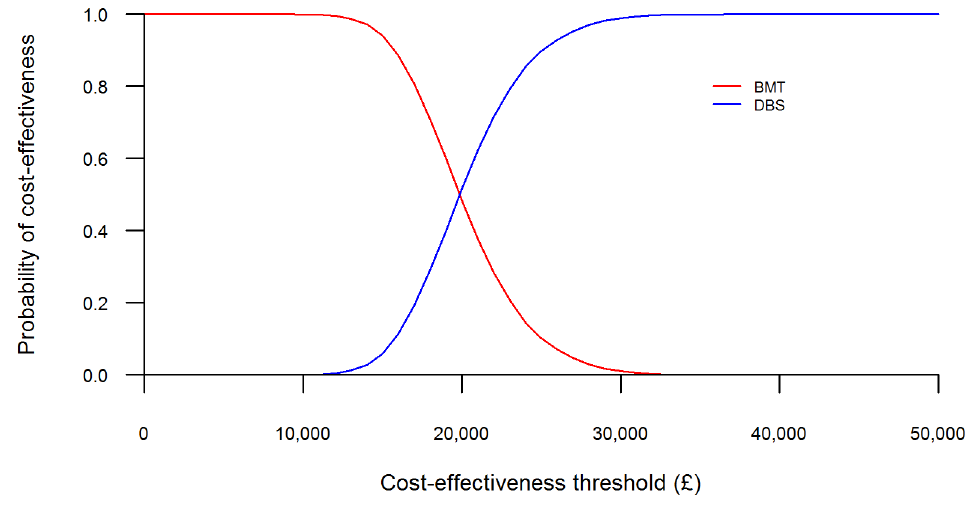
Fig 7. Cost-effectiveness acceptability